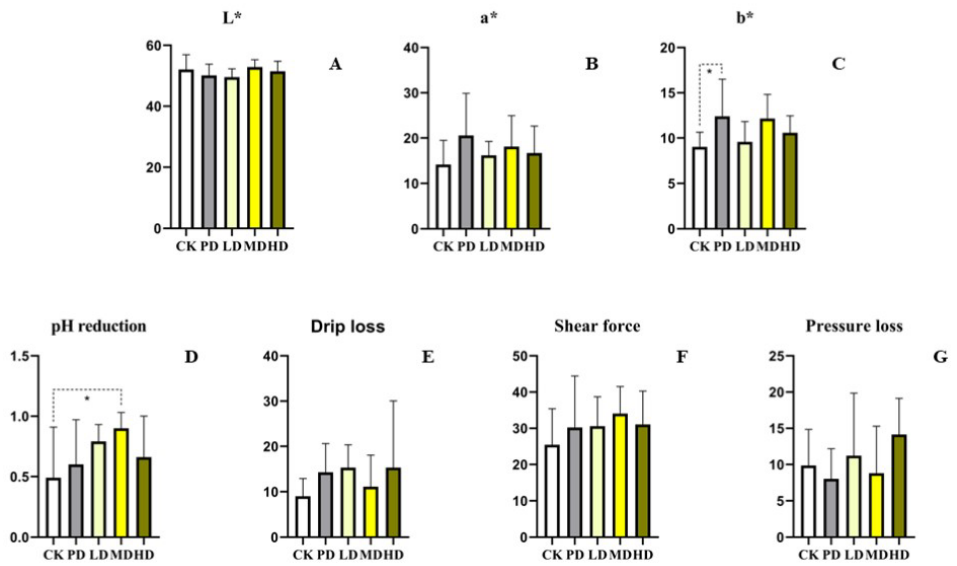
Figure 3. Effects of the fruit extract of K. coccinea on chest muscle of white-feather broilers ( A ) L*; ( B ) a*; ( C ) b*; ( D ) pH reduction of 24 h; ( E ) drip loss; ( F ) shear force; ( G ) pressure loss; Note: Dotted line: compare with CK group; Solid line: compare with PD group; * indicate significant differences between groups according to the Tukey test; Supplementary Materials Table S3.